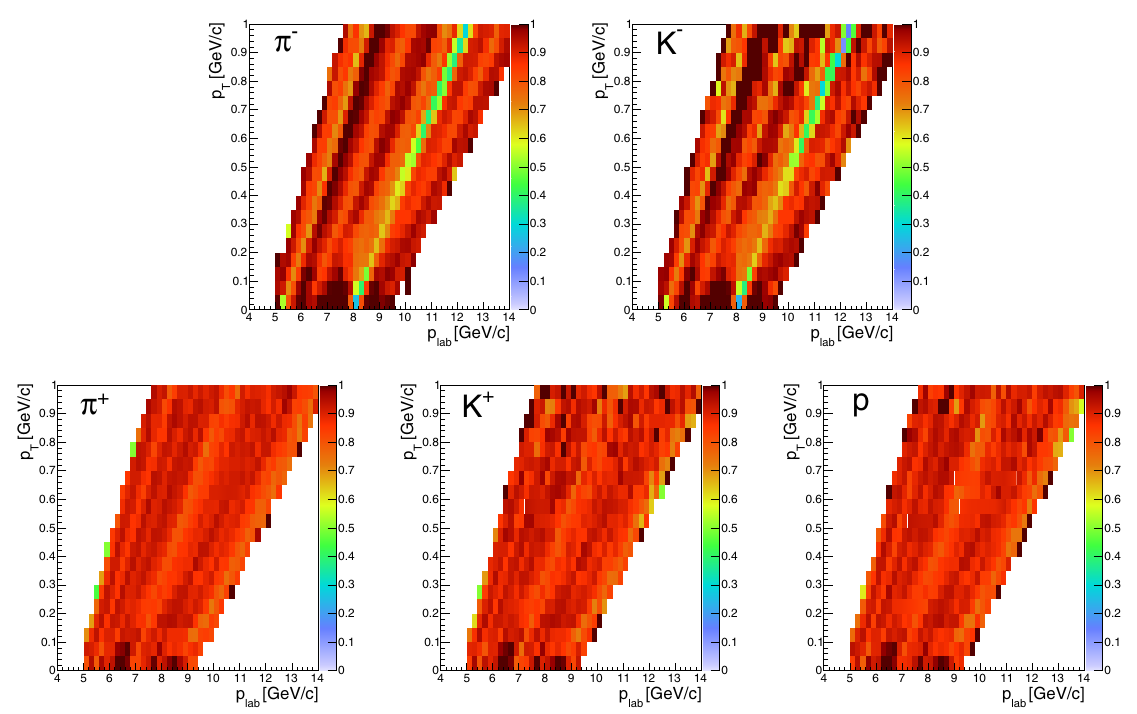
Fig. 47 Fraction of pixels providing a valid ToF measurement for p + p interactions at 158 GeV / c . Visible strips with lower value are due to groups of not working